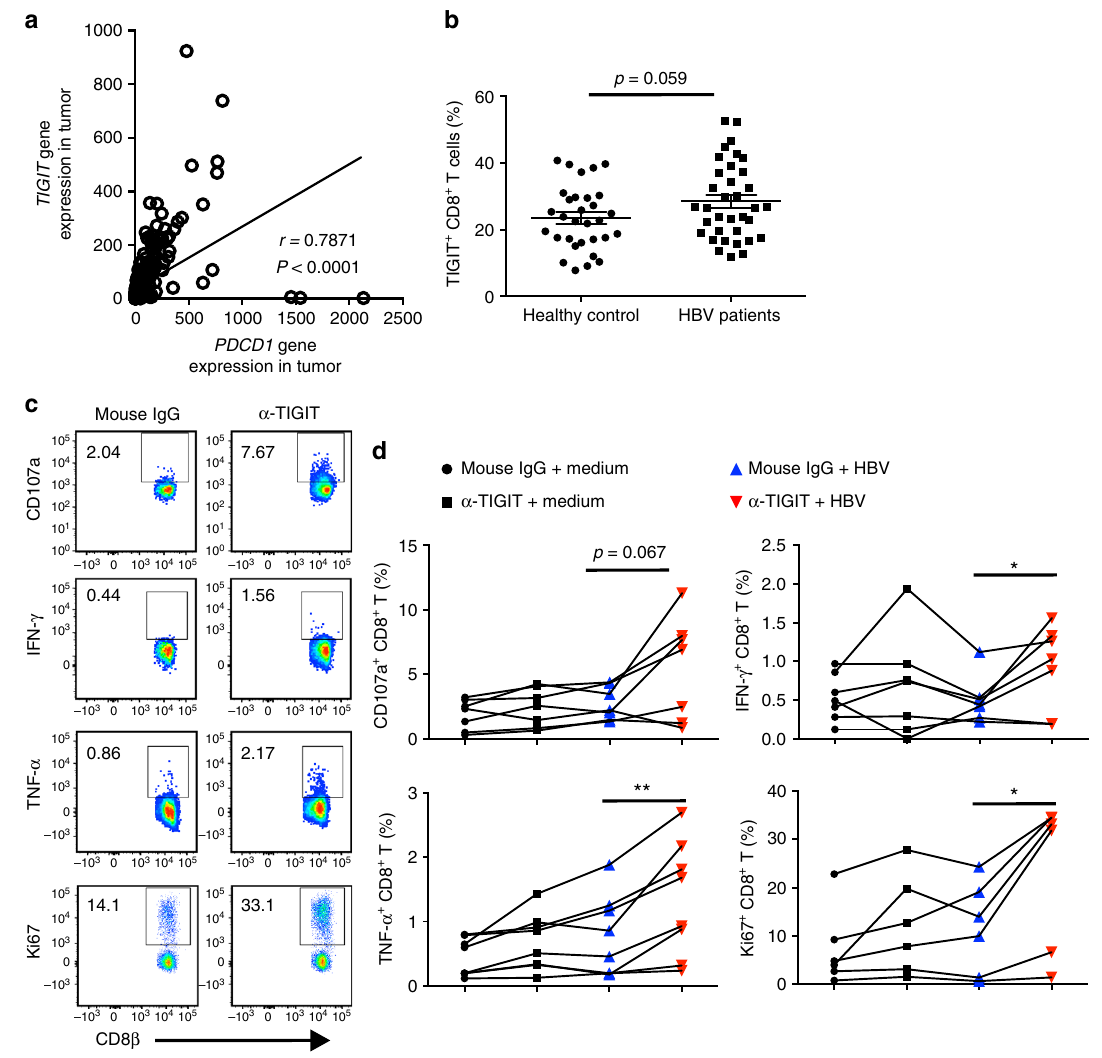
Fig. 9 TIGIT blockade enhances antiviral responses of CD8 + T cells from CHB patients. a Correlation between the gene expressions of TIGIT and PDCD1 in the HCC tumor tissue. Data are from the TCGA database. Spearman ’ s correlation coef fi cients ( r ) and P- values are shown. b TIGIT expression on peripheral blood CD8 + T cells in CHB patients and healthy controls was analyzed by fl ow cytometry ( n = 31, 35; Healthy controls, HBV patients). Each dot represents one individual. Statistically signi fi cant differences between the groups are presented as the mean ± SEM (two-tailed unpaired Student ’ s t -test). Data are pooled from three independent experiments. c , d The peripheral blood mononuclear cells (PBMCs) from HBV patients were stimulated with HBsAg peptide in the presence of α -TIGIT or control antibody for 10 days and were then tested by intracellular cytokine staining. c Representative fl ow cytometric graphs showing expression of CD107a, IFN- γ , TNF- α , and Ki67 in CD8 + T cells from samples treated with mouse IgG or α -TIGIT mAb. d The statistical percentages in ( c ) are shown ( n = 7, 7, 8, 6; CD107a, IFN- γ , TNF- α , Ki67). Statistically signi fi cant differences are calculated by two-tailed paired Student ’